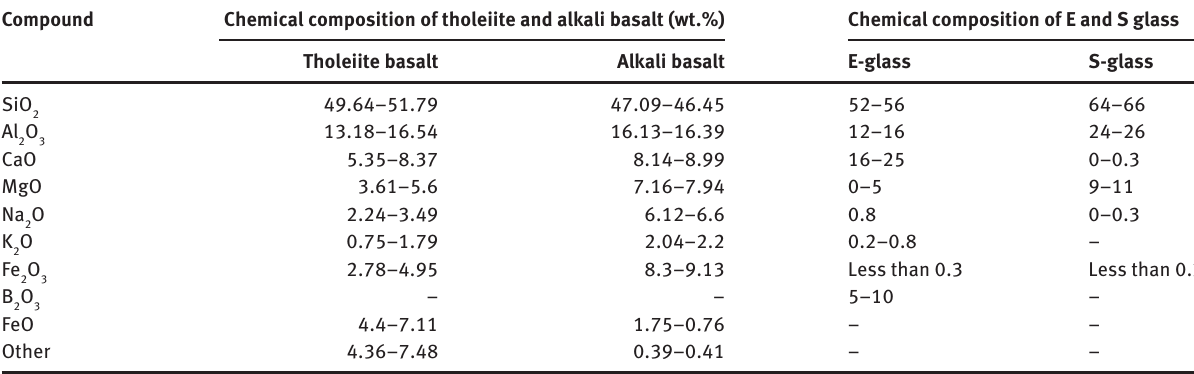
Table 1: Comparison between chemical composition of basalt and glass fiber [12, 13]. Compound Chemical composition of tholeiite and alkali basalt (wt.%)